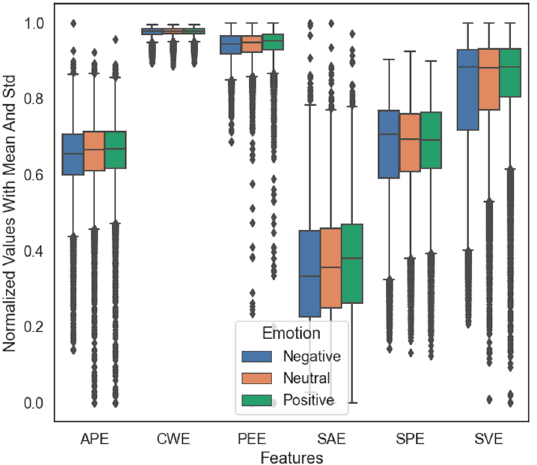
Figure 7. Normalized values with the mean and standard deviation for the six features of the three emotions.